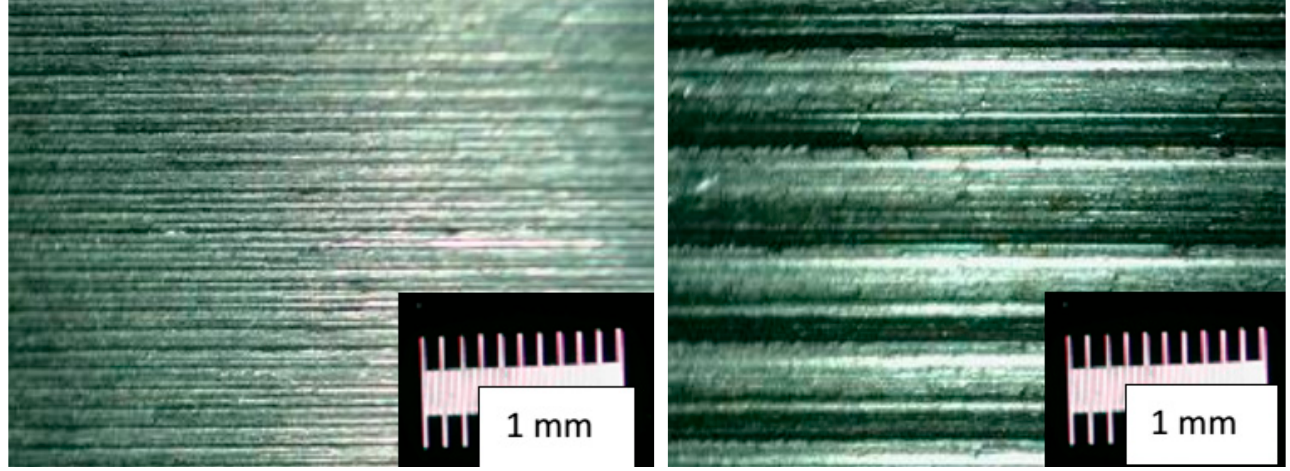
Figure 20. Sample surface with Ra = 0.435 µm (f1 = 0.14 mm/rot) and Ra = 6.323 µm (f5 = 0.6 mm/rot), which were obtained after turning.